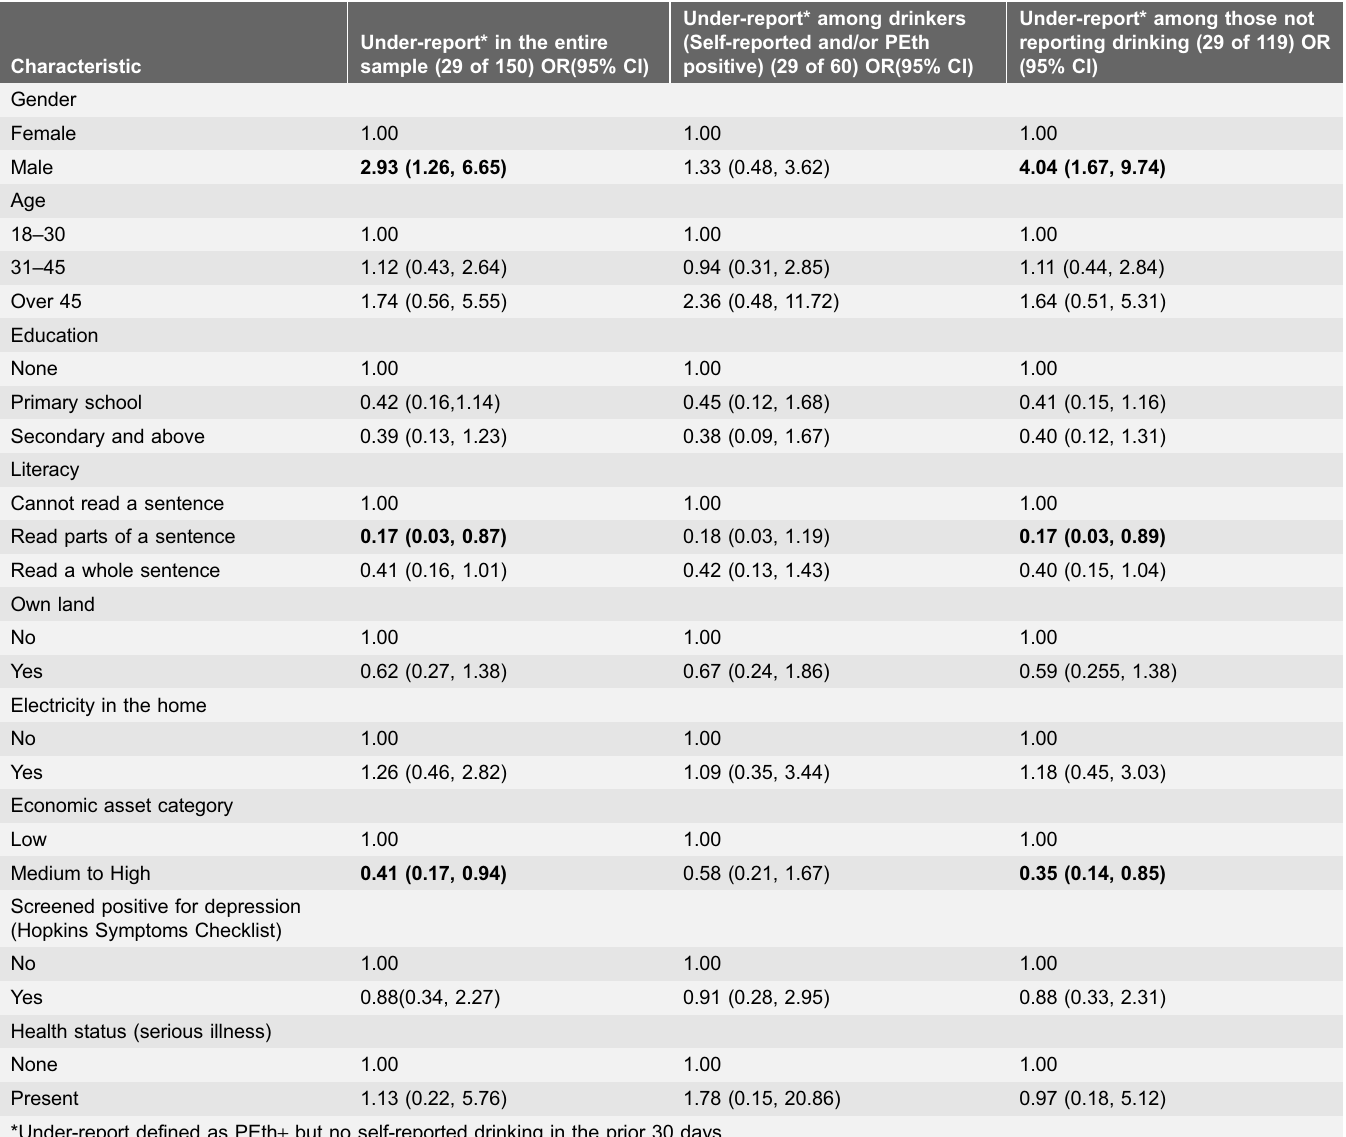
Table 4. Bivariate logistic regression to determine the predictors of under-reporting alcohol use.